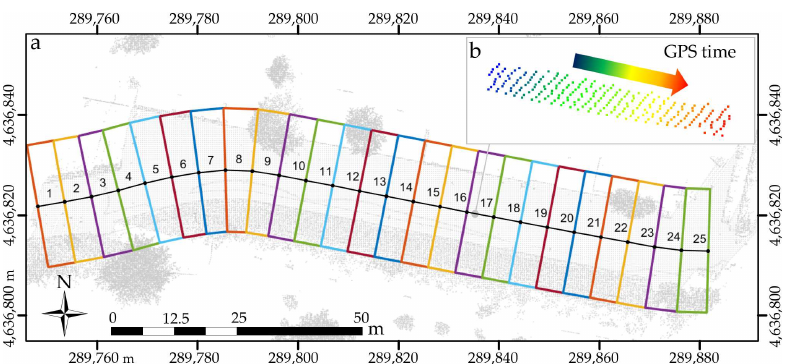
Figure 9. (a) Boxes used to divide the cloud into sub-clouds. (b) A zoomed excerpt of the points of the Figure 9. ( a ) Boxes used to divide the cloud into sub-clouds. ( b ) A zoomed excerpt of the points of the cloud corresponding to the MLS track. cloud corresponding to the MLS